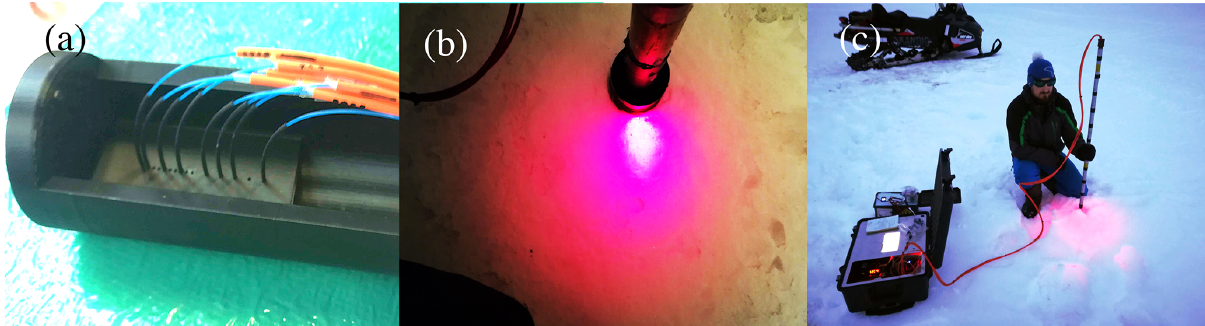
Figure 2. (a) Probe head interior. Source and detecting fibres were held in place with heat shrink tubes and glue. Fibres’ bend radii are meant to respect the minimum long-term limit of 40mm. (b) Probe head inserted in a 2in. auger hole drilled in sea ice. (c) Probe operated on sea ice close to Qikiqtarjuaq Island on the coast of Baffin